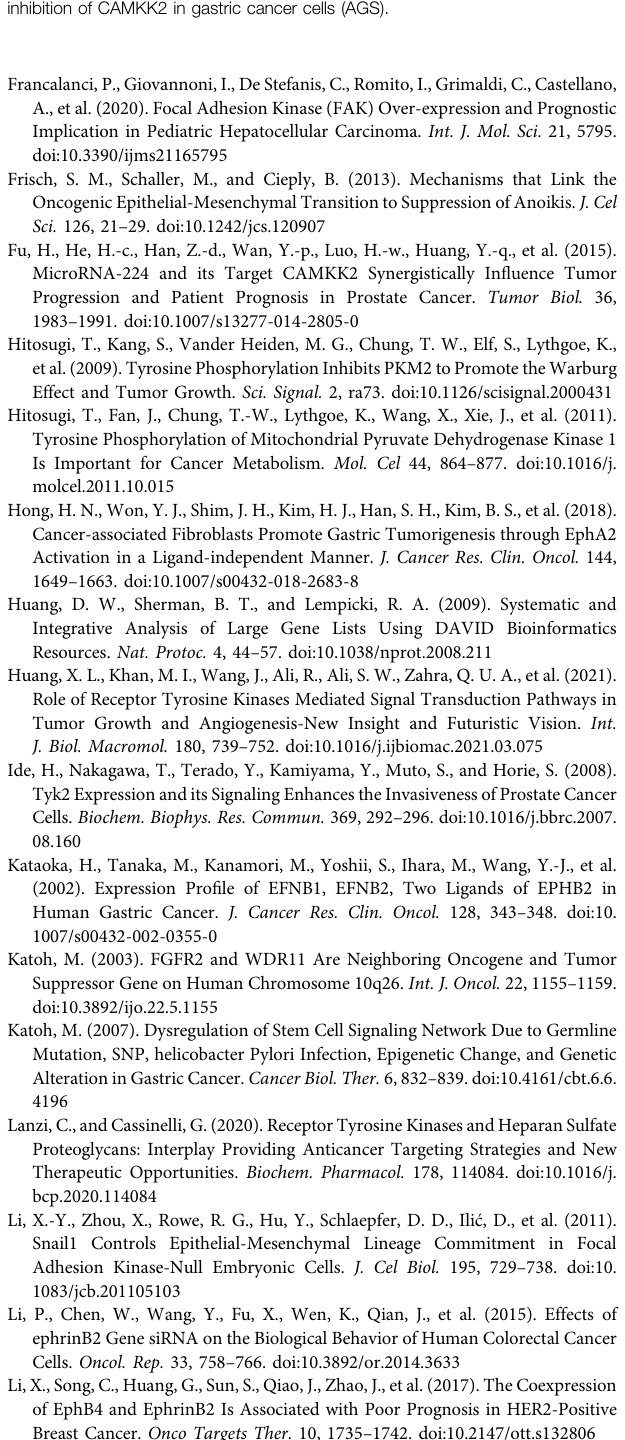
diagram shows the protein identi fi cations between control and STO-609 treated samples across the triplicates. Supplementary Table S1 | List of phosphopeptides identi fi ed and quanti fi ed in LFQ-based quantitative phosphoproteomic approach in gastric cancer cells (AGS) upon CAMKK2